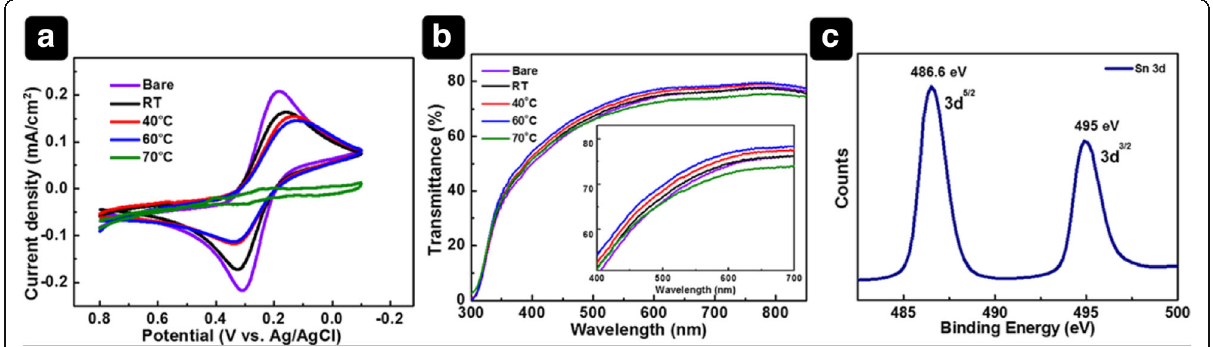
Fig. 5 Various analyses for the films. ( a ) CV curves in redox solution system and ( b ) transmission spectra of bare FTO and SnO 2 films electrodeposited at different bath temperatures in redox solution system. ( c ) XPS Sn 3d spectrum of thermally treated SnO 2